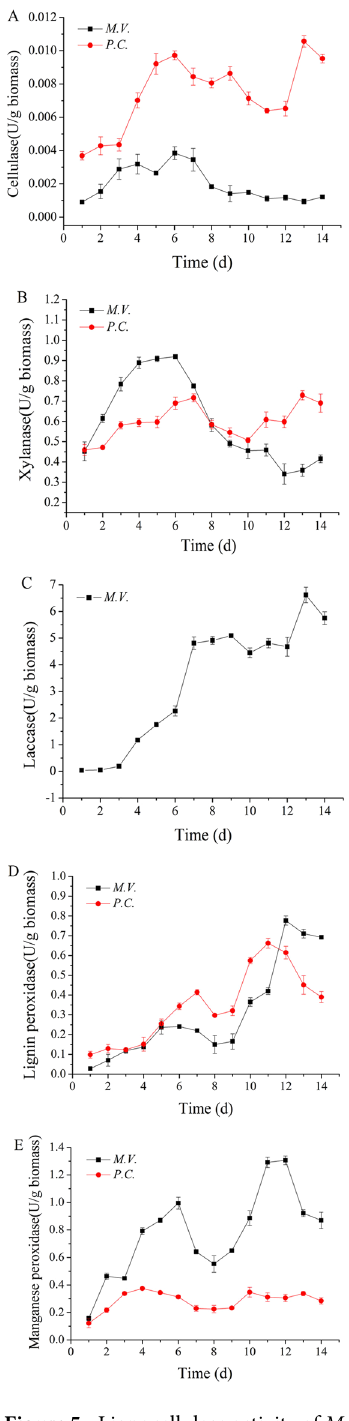
Figure 5. Lignocellulase activity of M . V . and P . C . ( A ) Stands for cellulase activity; ( B ) stands for Xylanase activity; ( C ) stands for Laccase activity; ( D ) stands for Lignin peroxidase activity; ( E ) stands for Manganese peroxidase activity. Each value is the mean of three